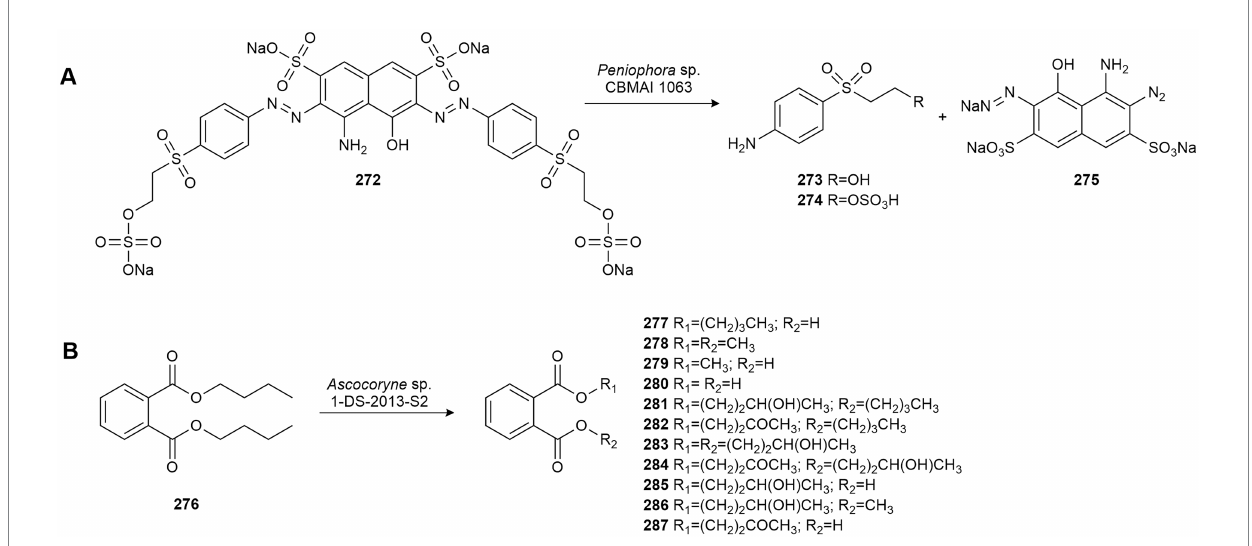
FIGURE 13 Biodegradation of a synthetic dye and a plastic polymer. (A) Reactive black 5 ( 272 ) dye biodegradation by Peniophora sp. CBMAI 1063 (Bonugli-Santos et al., 2016). (B) Biodegradation of di- n -butyl phthalate ( 276 ) plastic polymer by Ascocoryne sp. 1-DS-2013-S2 (Carstens et al.,